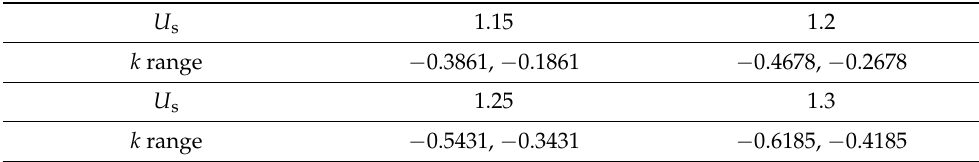
Table 1. Range of k values for different voltage